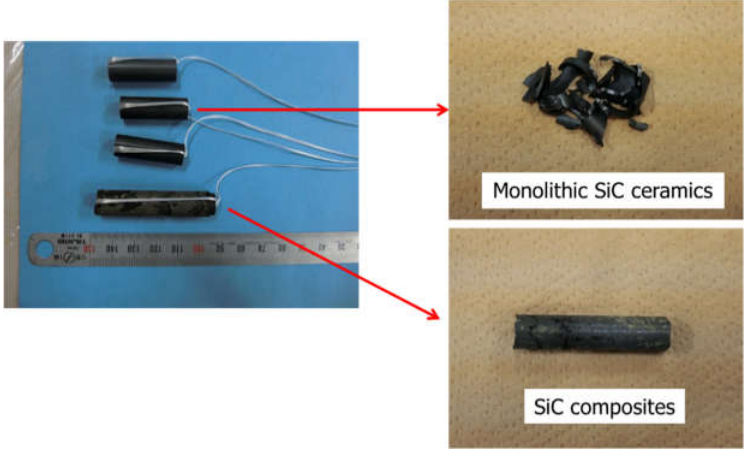
Figure 11. The monolithic SiC ceramic tubes and the LPS SiC composite tube before and after the thermal shock tests (1200 °C for 30 min to ambient temperature).